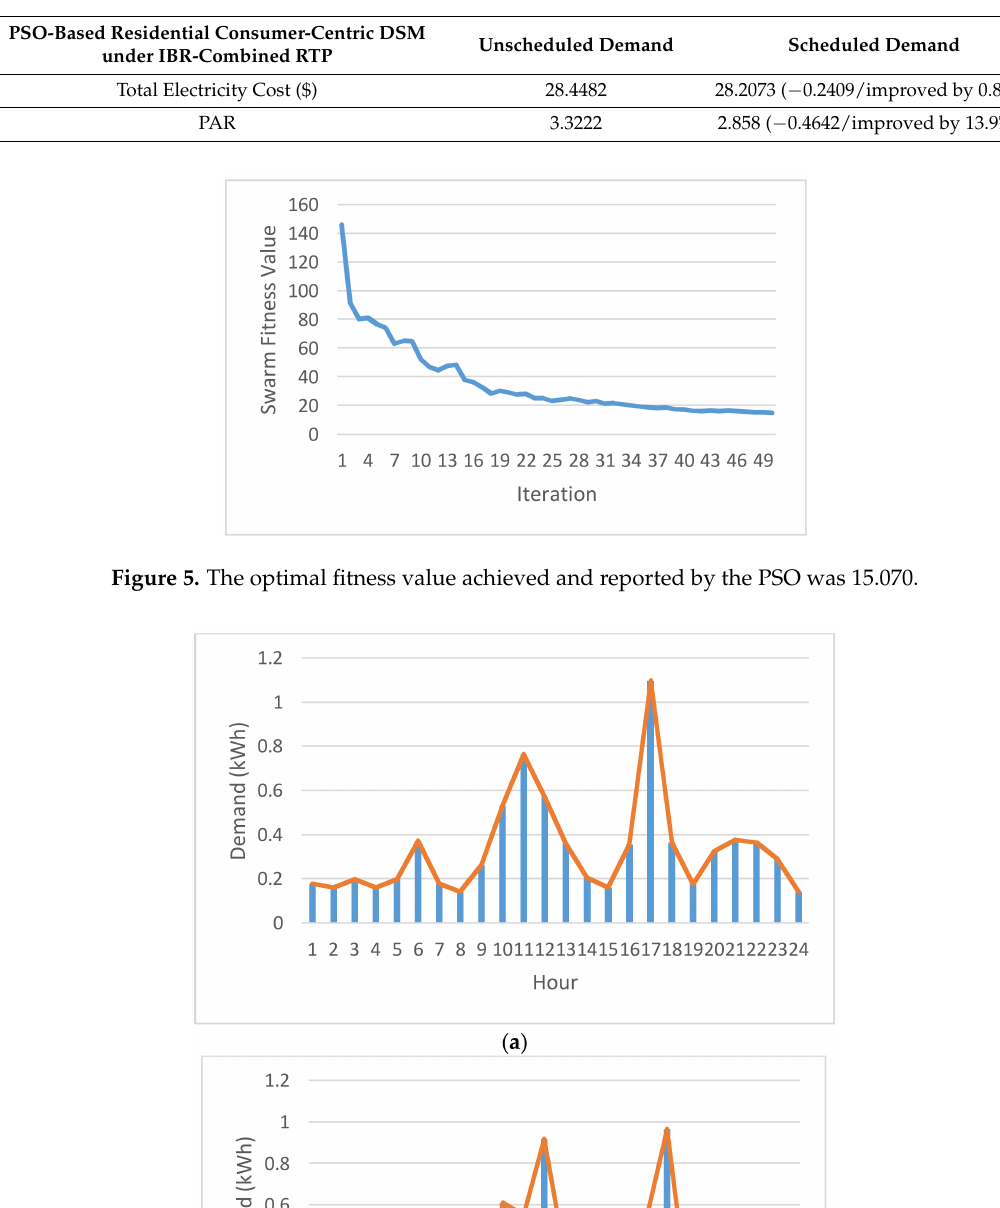
Table 4. Economic benefit and phenomenal reduction of PAR achieved in this paper.